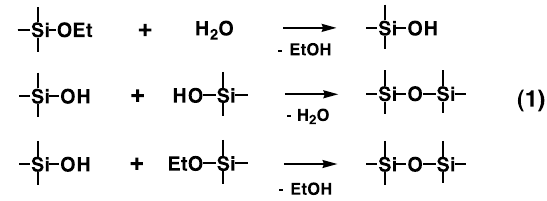
Fig. 2 . Hydrogen bonding in hybrid